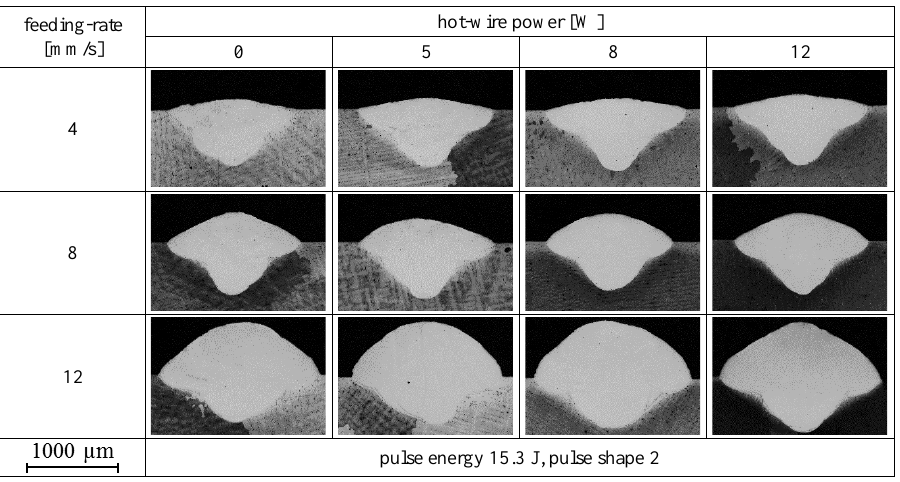
Figure 14. Influence of the hot-wire power and the wire-feeding rate on the weld seam geometry.